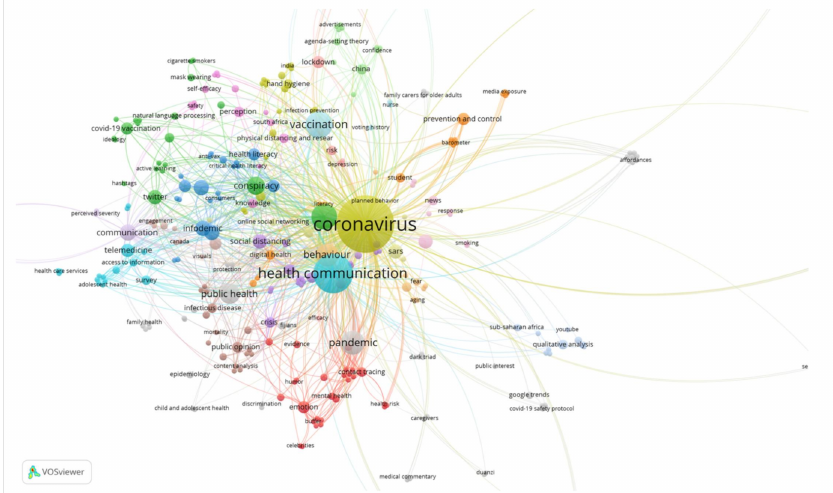
Figure 7. Map of keywords and their confluence in articles published in